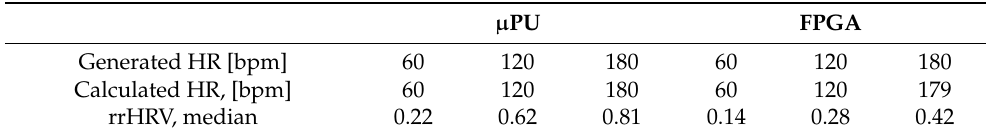
Table 1. HR and HRV analysis at a range of heart rates.